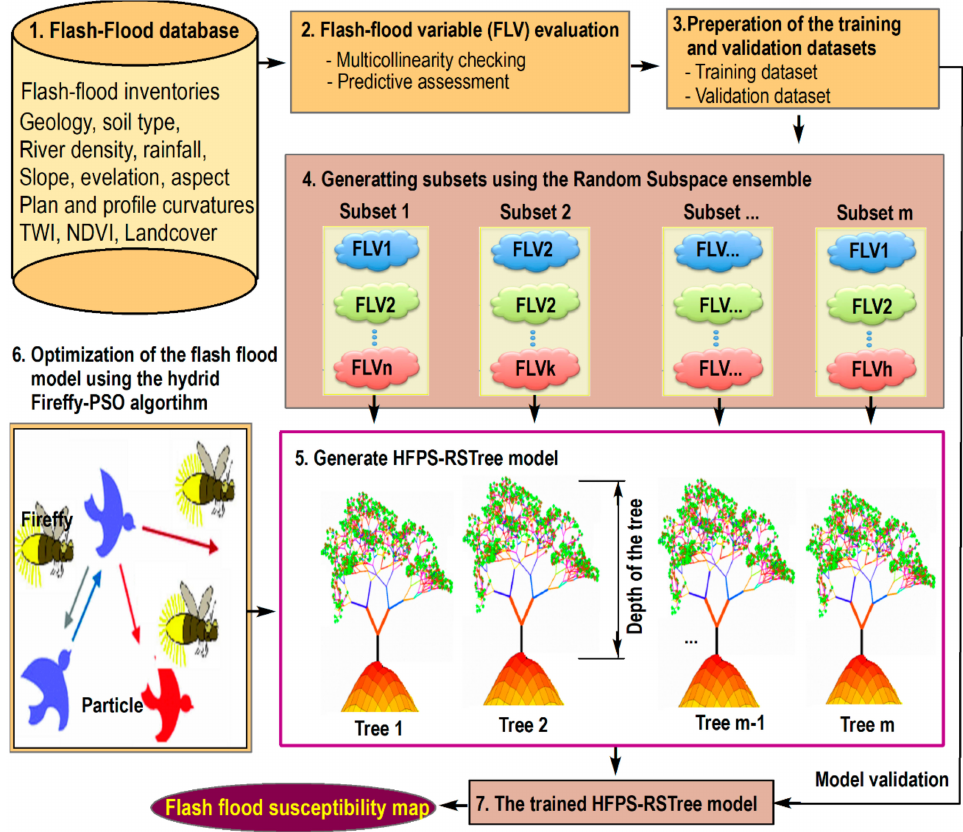
Figure 3. The proposed HFPS-RSTree model for flash flood susceptibility